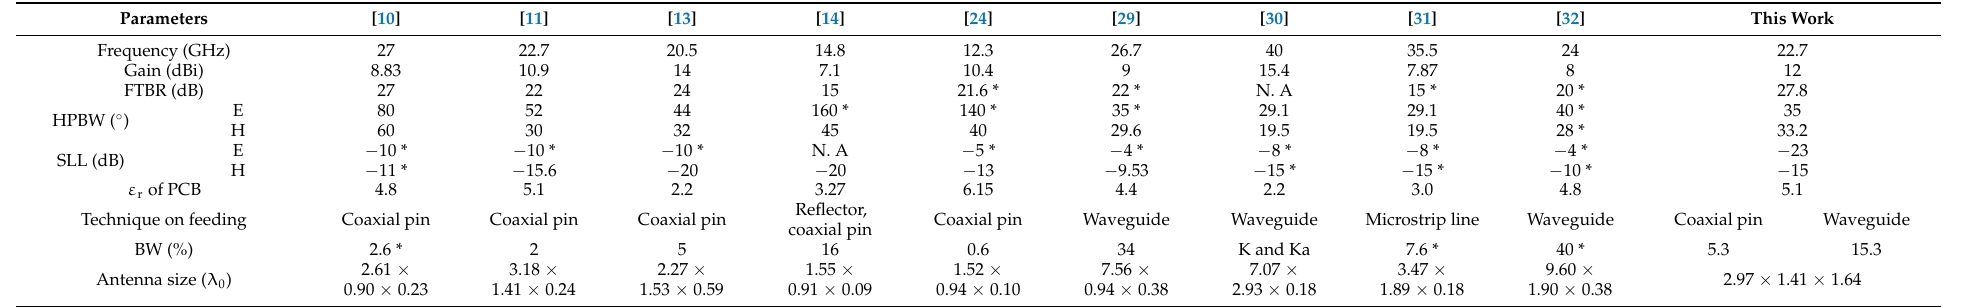
Table 2. Summary of recent